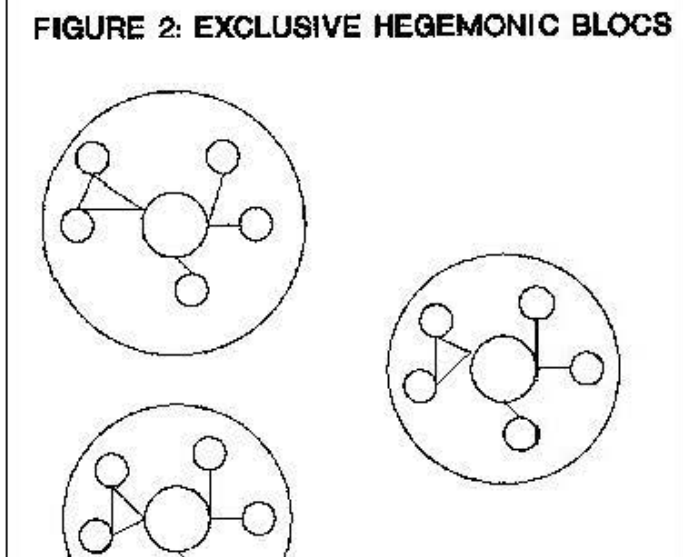
FIGURE 2: EXCLUSIVE HEGEMONIC